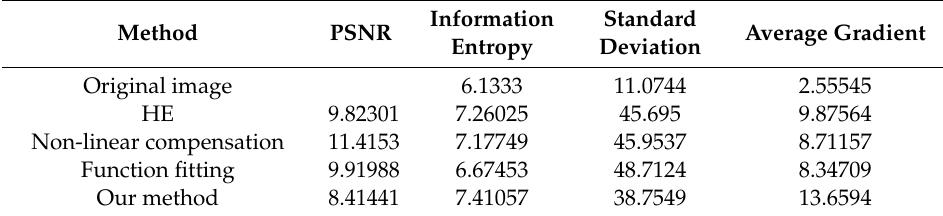
Table 3. Indicators comparison of local magnification maps.